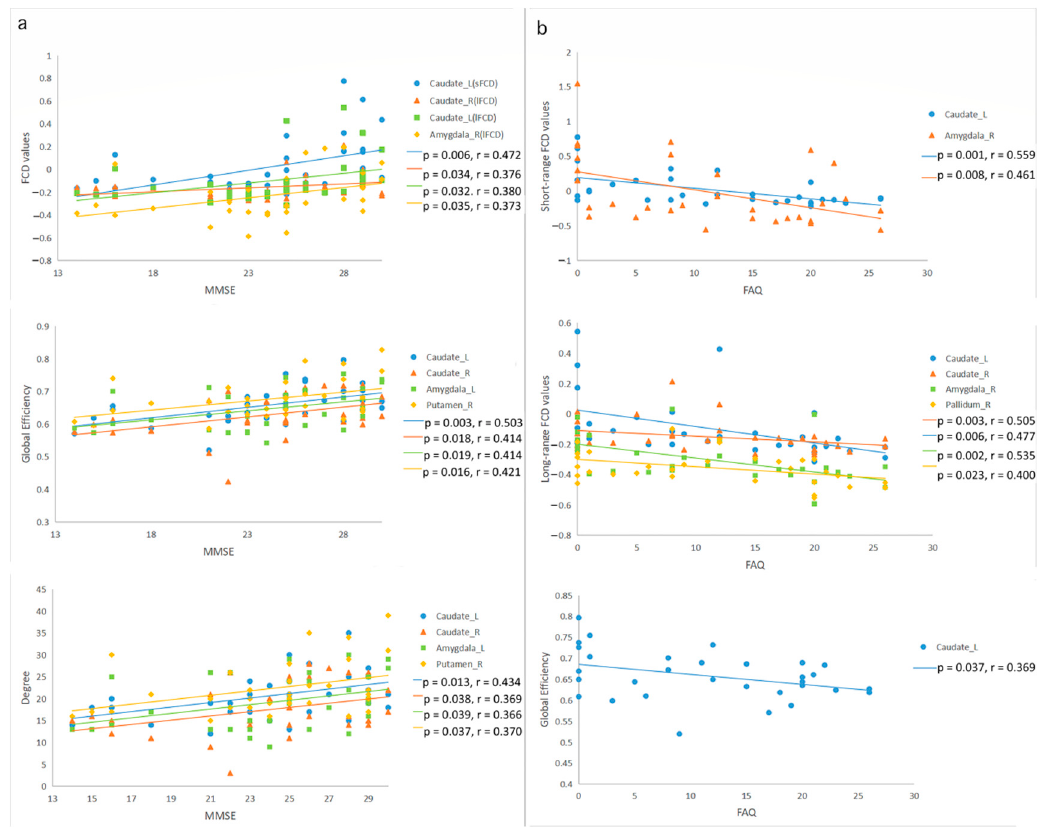
Figure 4. ( a ) Scatterplot of FCD and graph theory analyses in specific regions plotted against MMSE score. ( b ) Scatterplot of FCD and graph theory analyses in specific regions plotted against FAQ score. FAQ scores were negatively correlated with short ‐ range FCDs in the left caudate and the right amygdala. The correlation between the FAQ scores and long ‐ range FCDs was also negative in the bilateral caudate, the right amygdala, and the right pallidum. Addi ‐